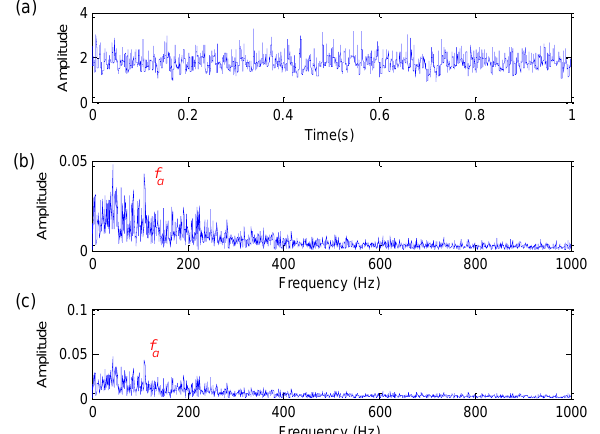
Figure 7. Analysis results obtained by STH method for simulation signal: ( a ) Time domain waveform; ( b ) amplitude spectrum; ( c ) envelope spectrum.